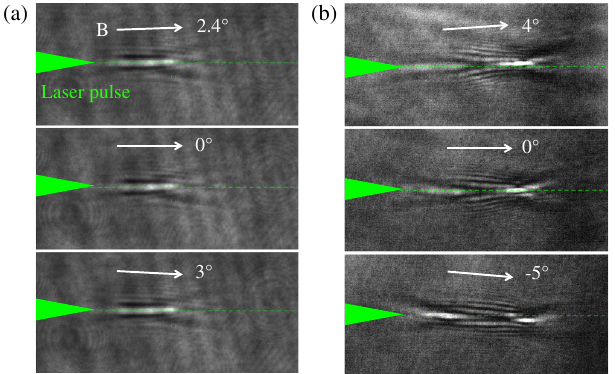
FIG. 4. Shadowgraph images with different tilting angles (a) in the case of low-intensity prepulse (ASE level ∼ 10 11 W = cm 2 ) for the gas density ∼ 1 . 1 × 10 19 cm − 3 and (b) high-intensity prepulse